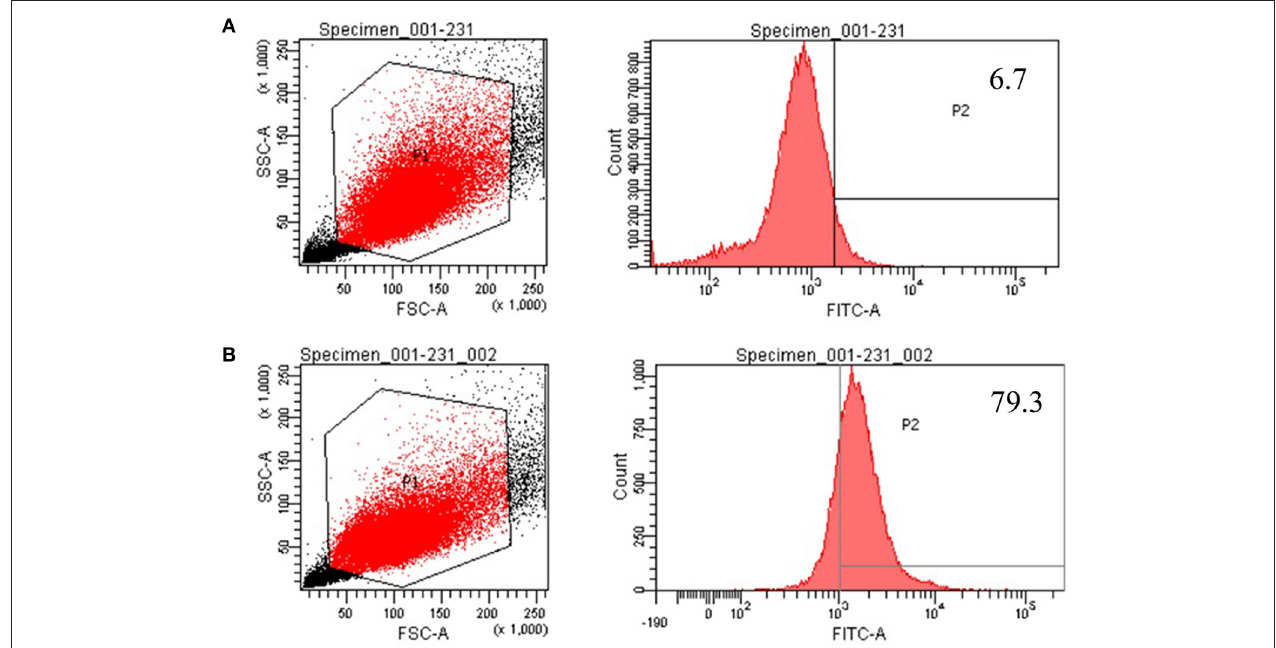
FIGURE 3 | The identification results of ALDH + with flow cytometry. (A) The proportion of ALDH + for ordinary MDA-MB-231 was 6.7%. (B) The proportion of ALDH + for MDA-MB-231 breast cancer stem cell was 79.3%.